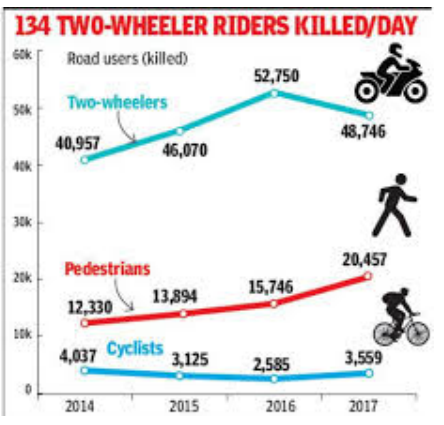
Figure 1. Representation of rate of accidents in two